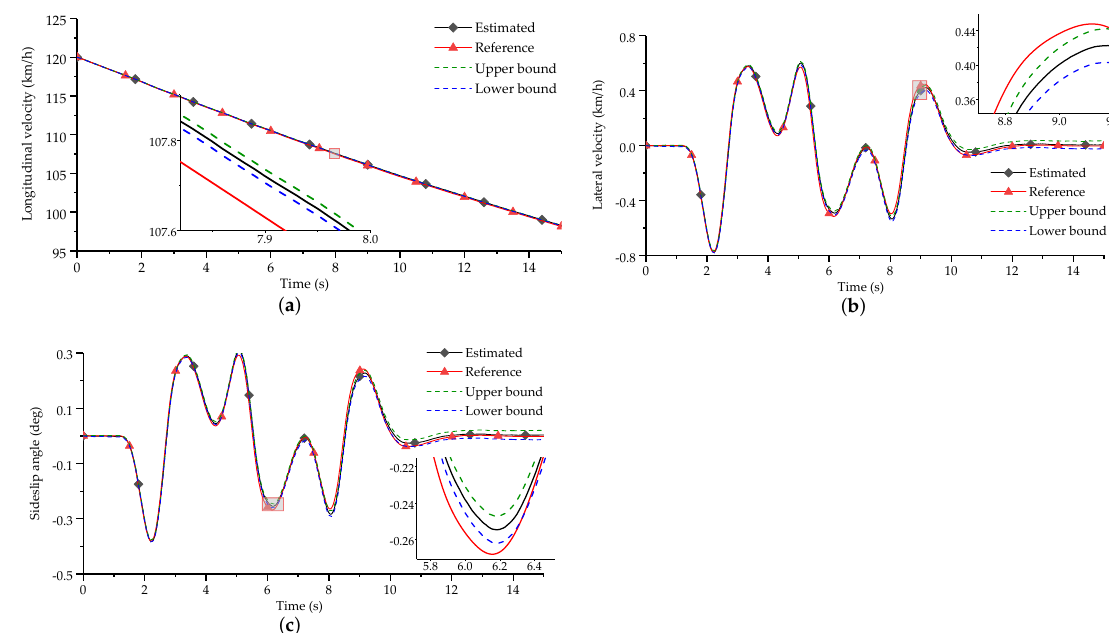
Figure 10. Results of the UKF-based strategy under the DLC maneuver. ( a ) Longitudinal velocity; ( b ) Lateral velocity; ( c ) Vehicle sideslip angle.